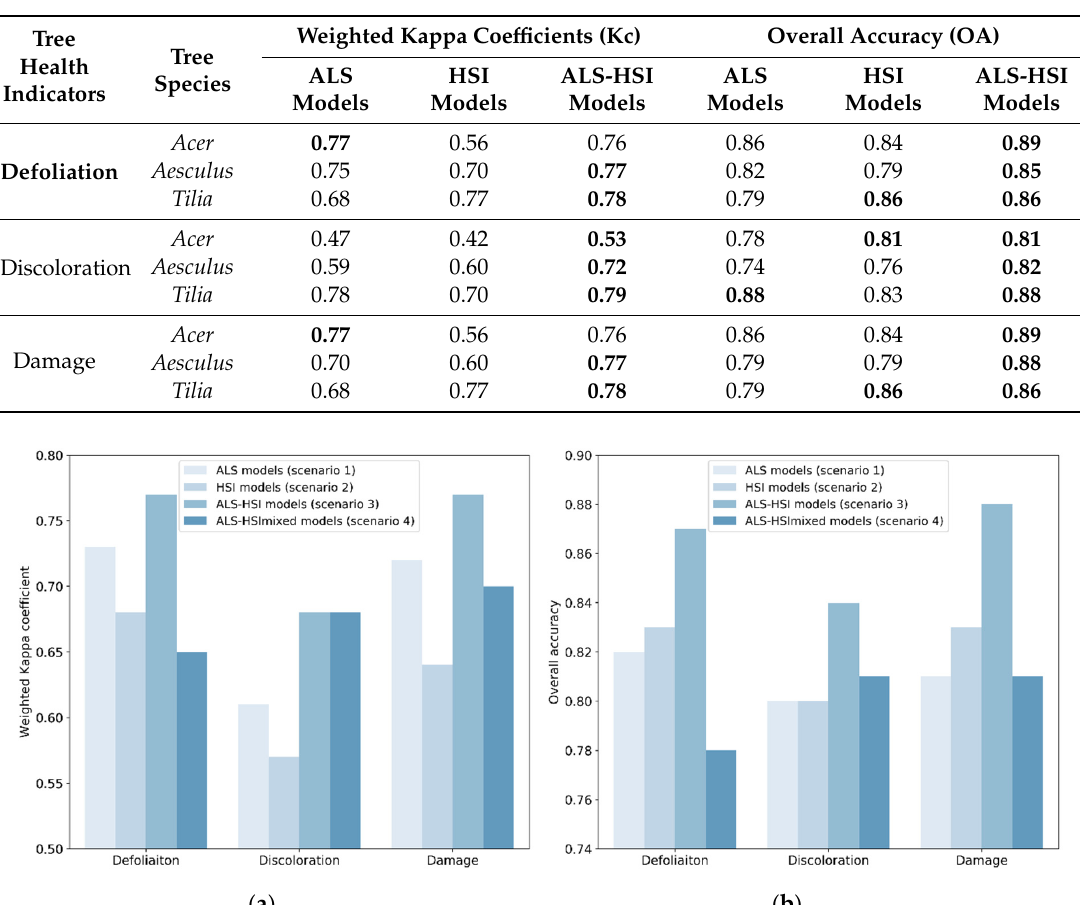
Table 4. Classification results in scenarios 1–3 in which Random Forest models were trained and tested using ALS indices (ALS models in scenario 1), hyperspectral imagery (HSI) indices (HSI models in scenario 2) and their combination (ALS-HSI models in scenario 3), respectively, for individual tree species (datasets 1–3, cf. Section 2.2). The highest accuracies for predicting each tree health indicator